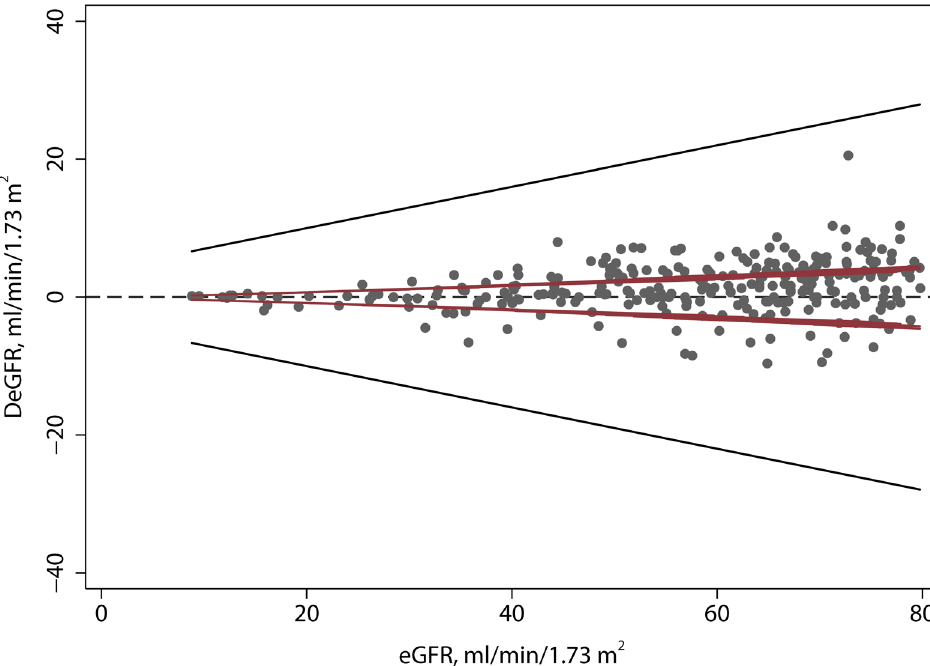
Fig 6. Comparison of analytical variation, biological variation and unconditional discordance. The inner lines (maroon) are the limits of analytical variation and the outer (black) lines are the limits of biological variation. Forty-two percent of the discordances exceed the limits of analytical variation. None of the discordances exceed the limits of biological variation.